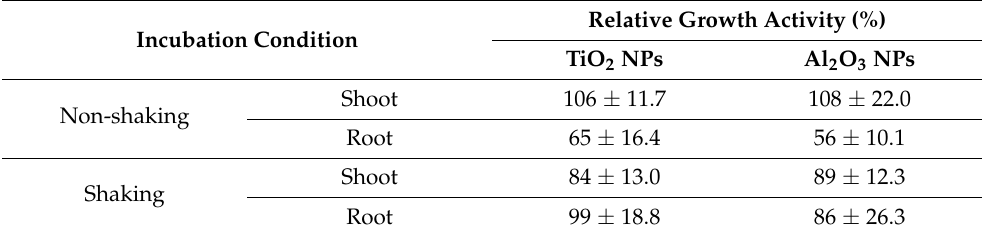
Table 2. Relative root and shoot growth of Lactuca sativa under non-shaking and shaking